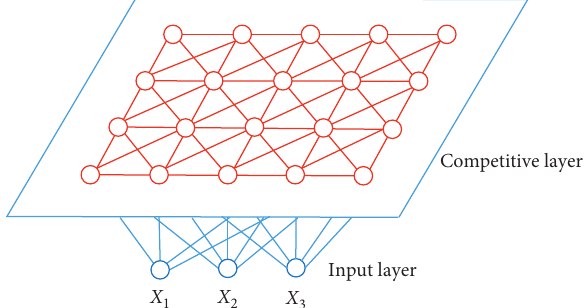
Figure 2: The structure of SOM neural